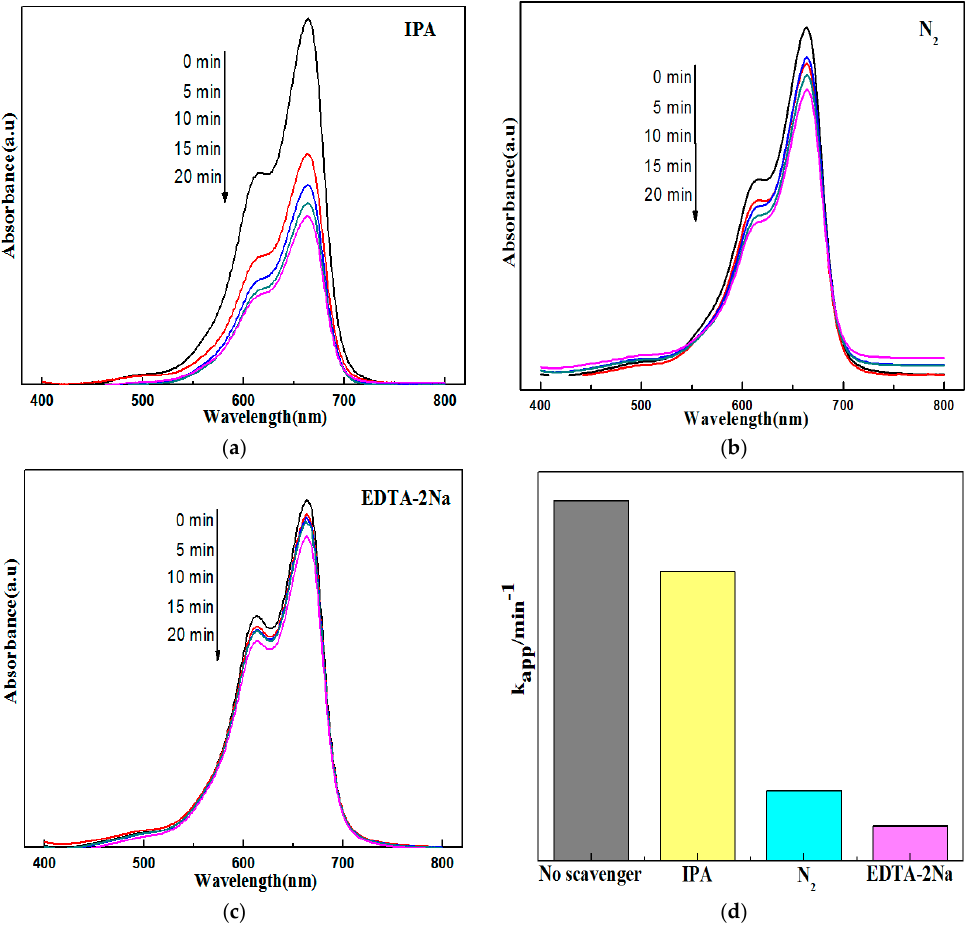
Figure 9. Photocatalytic degradation of MB with Ag@AgCl/Bi 2 O 2 CO 3 in the presence of various scavengers under visible light. ( a ) IPA; ( b ) N 2 ; ( c ) EDTA-2Na; and ( d )comparison of the visible-light photocatalytic activity obtained using rate constant kapp.